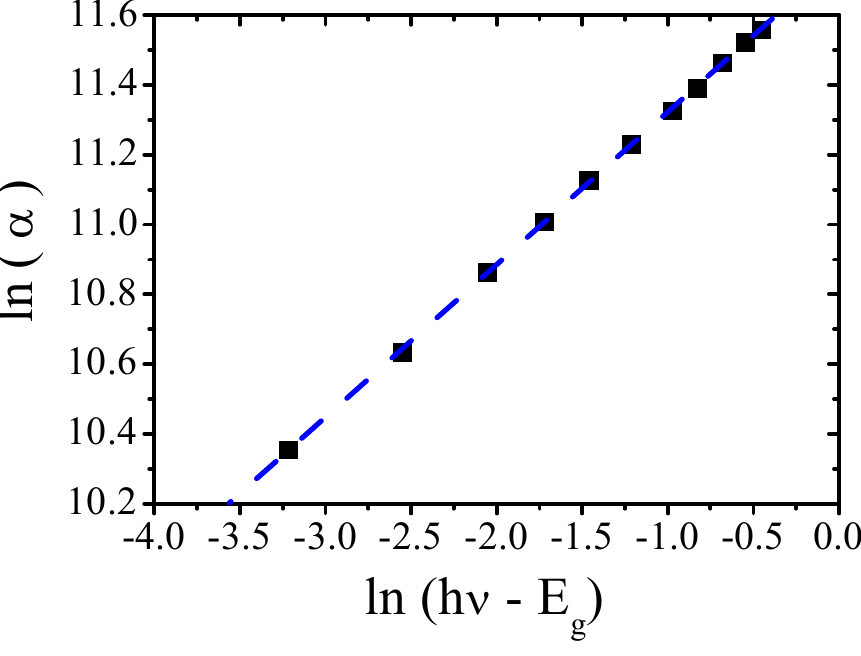
Figure 9. Relation between ln ( α ) and ln(h ν‐ Eg) for CdS films.